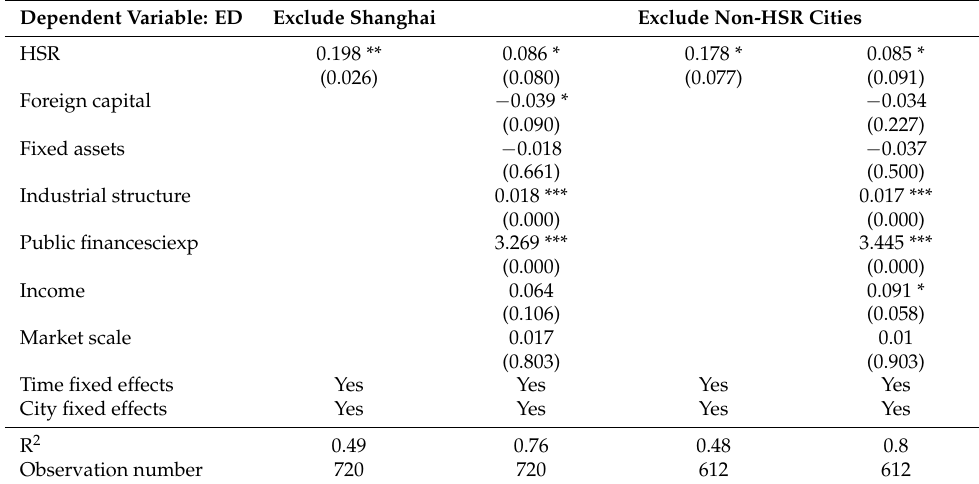
Table 7. Robustness